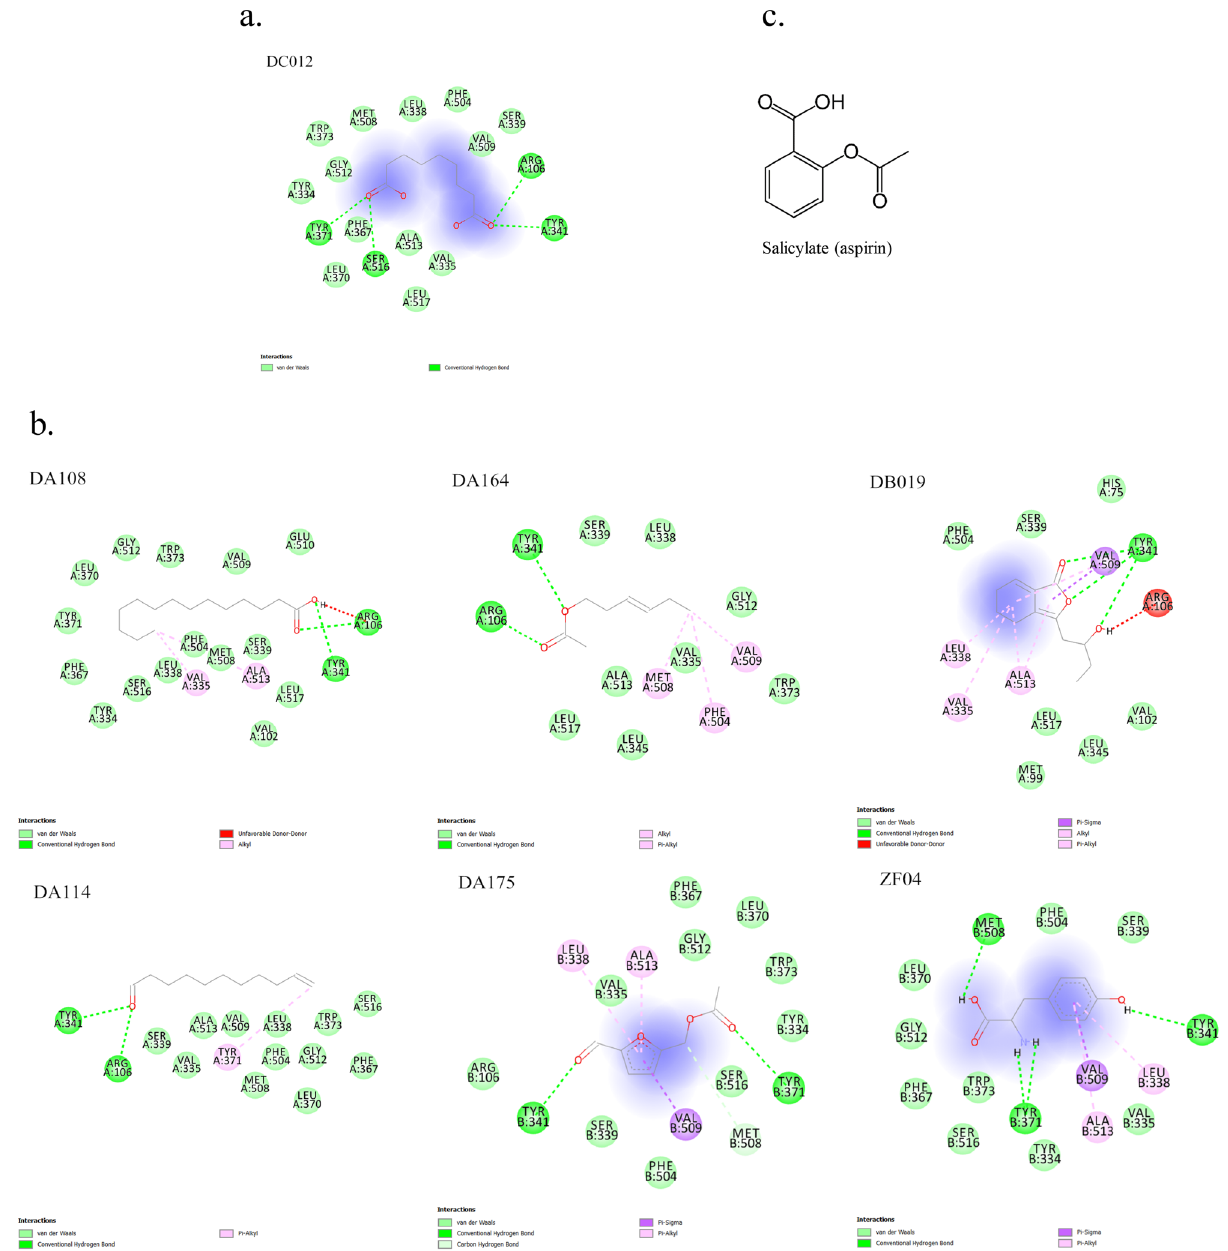
Figure 4. Ligand–target interactions for compounds forming hydrogen bonds with catalytic triad residues of prostaglandin-endoperoxide synthase 2. ( a ) Compounds forming hydrogen bonds with three catalytic triad residues. ( b ) Compounds forming hydrogen bonds with two catalytic triad residues. ( c ) Structure of inhibitor of prostaglandin-endoperoxide synthase 2, salicylate (aspirin). DA108 tetradecanoic acid, DA114 10-undecenal, DA164 trans,trans-2,4-hexadienyl acetate, DA175 5-acetoxymethylfurfural, DB019 senkyunolide F, DC012 azelaic acid, ZF04